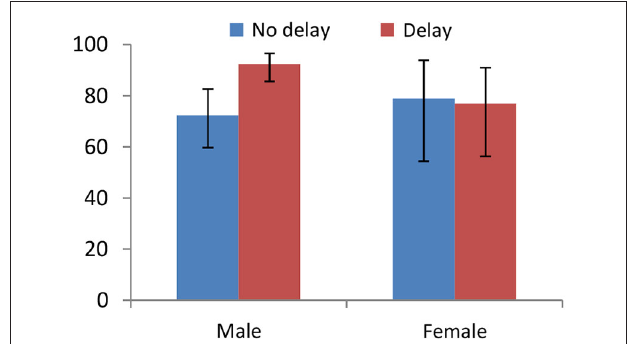
fraction of accepted offers rises with respect to the baseline when allowed to change their decisions ( p = 0.016), while the treatment differences are not significant in women ( p = 0.456). The results are again robust if we restrict the analysis to low offers. In this case, the differential treatment effects are not significantly different across genders ( N = 210, p =